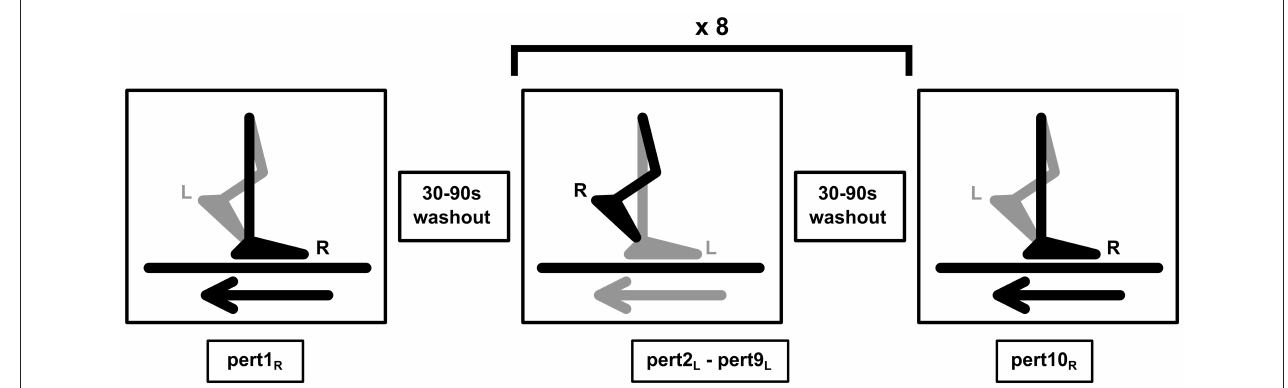
FIGURE 1 | Gait perturbation protocol [image previously shown in McCrum et al. (2019b)]. The right leg (R) was perturbed by the treadmill belt acceleration first (Pert1 R ), followed by eight perturbations (Pert2 L – Pert9 L ) to the left leg (L), and the final perturbation (Pert10 R ) was again applied to the right leg (R). In all, 30–90s of unperturbed walking occurred between each perturbation. The perturbation was designed to cause a forward rotation and acceleration of the upper body, relative to the lower body, leading to a forward loss of dynamic